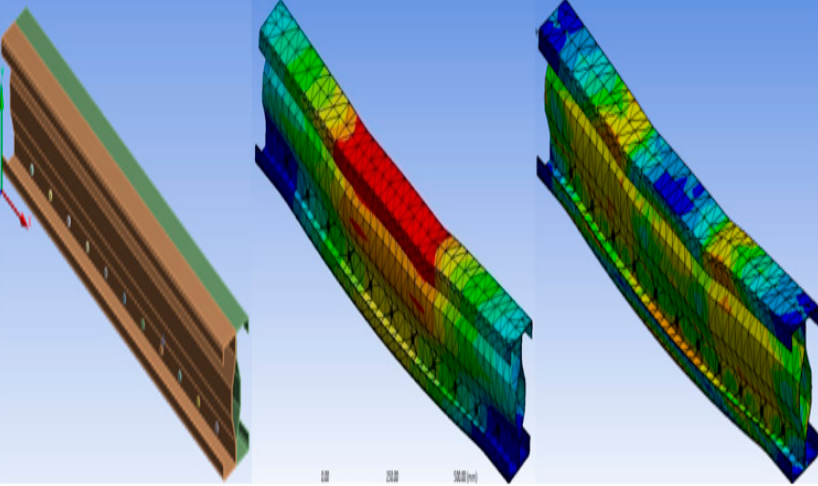
Figure 3. Buckling and stress distribution of B2B100.